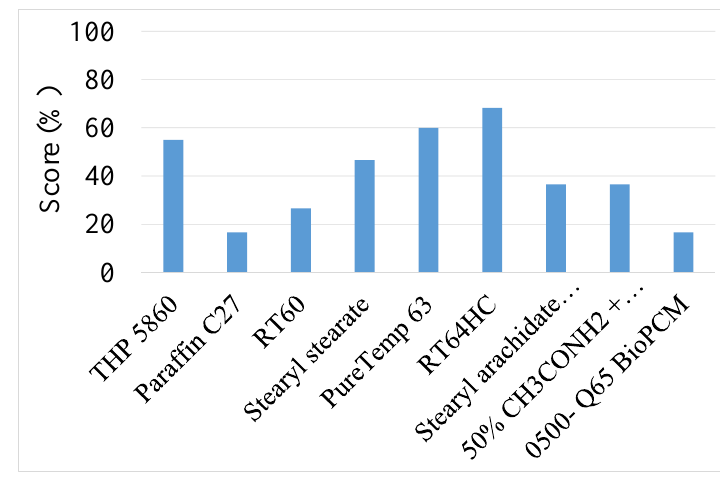
Figure 4. Score obtained by each of the pre-selected PCM candidates in Scenario 1 for the CON system. The best three PCM candidates, i.e., RT64HC, PureTemp63, and TH5860, were characterized in